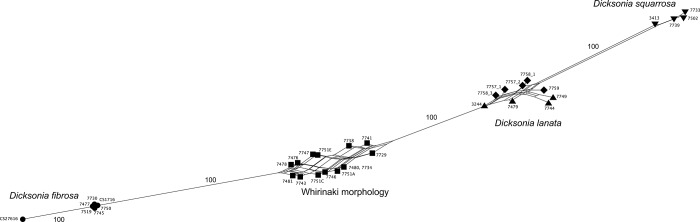
NeighborNet phylogenetic network derived from 1244 ddRAD-Seq loci.Dicksonia lanata subsp. lanata samples are represented by upward facing triangles and D. lanata subsp. hispida samples are shown as diamonds. Bootstrap support values are shown.